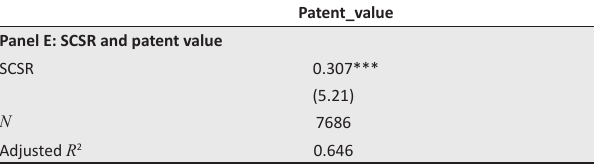
TABLE 5E: Further